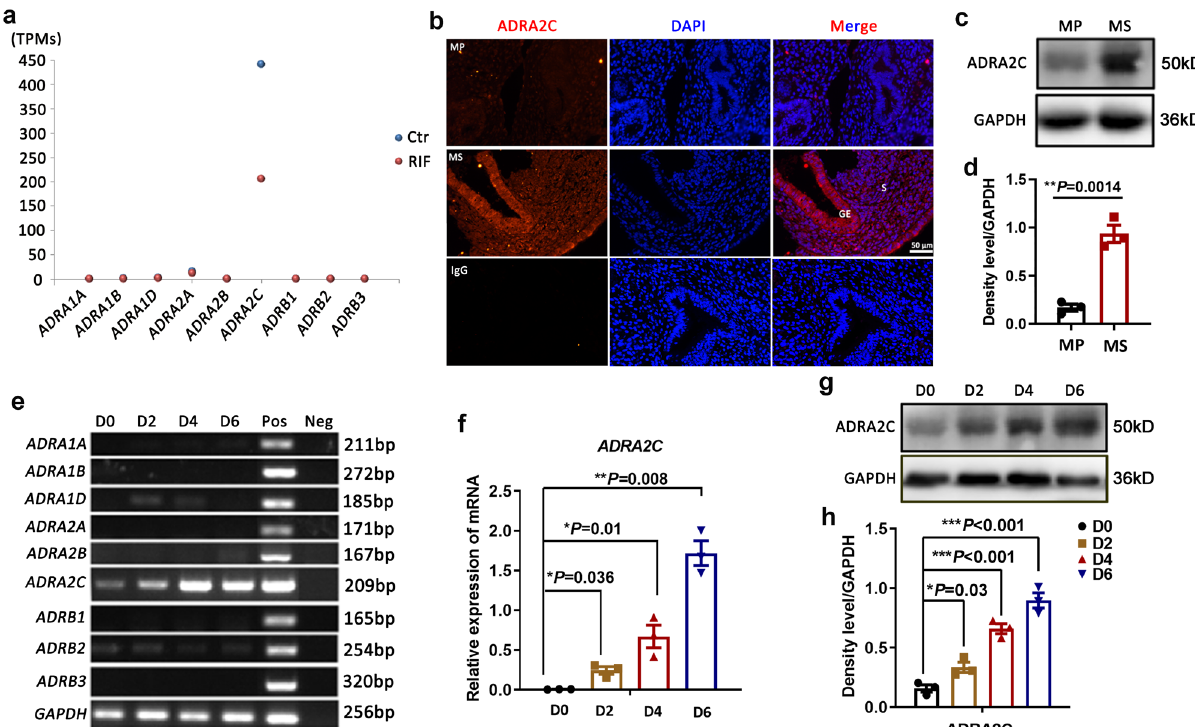
Fig. 2 ADRA2C was robustly expressed in HESCs during decidualization. a Analysis of the alterations transcriptomic patterns of adrenergic receptors in RIF versus control women. TPM transcripts per million. b Tissue immuno fl uorescence for ADRA2C protein location in the Mid-proliferative stage and Mid- secretory phase of human endometrium. Scale bars, 50 μ m. MP mid-proliferative phase (day 8 of the menstrual cycle), MS mid-secretory phase (day LH + 7), S stroma, GE glandular epithelium, IgG for control. c Western blotting for the ADRA2C protein level between mid-proliferative and mid-secretory phase of endometrial tissues. d Relative fold change in density in c . e RT-PCR screen for the expression of different adrenergic receptors during decidualization of HESCs. Pos positive control, Neg negative control. f Quantitative RT-PCR analysis of ADRA2C mRNA level in HESCs during decidualization. g Western blot for ADRA2C protein expression before and after HESCs differentiation. D0, HESCs cultured in vitro before differentiation; D4, HESCs induced differentiation on day 4 in vitro. h Relative fold change of density levels for g